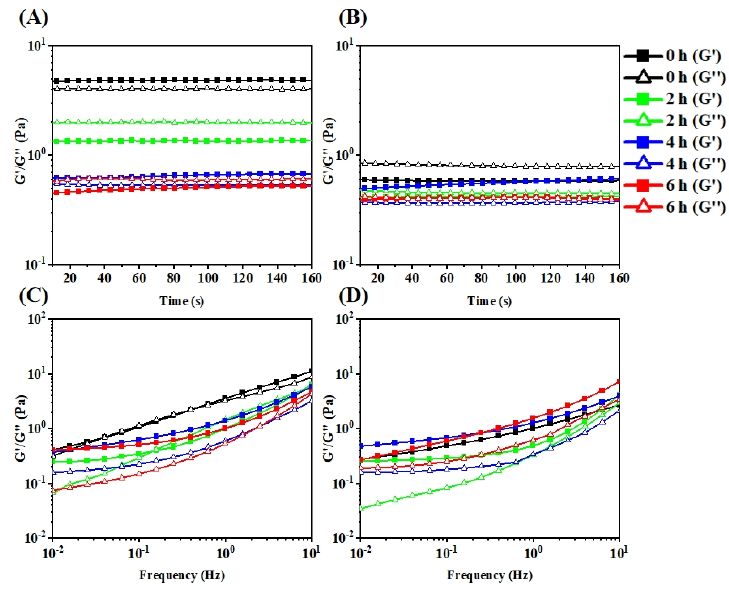
Figure 9. The storage modulus (G ′ ) (solid symbols), loss modulus (G ″ ) (open symbols) of κ -carrageenan, DC-2, DC-4, and DC-6 under the time range of 0–160 s at ( A ) 4 °C and ( B ) 25 °C and under the frequency scope of 0.01–10% at ( C ) 4 °C and ( D ) 25 °C.